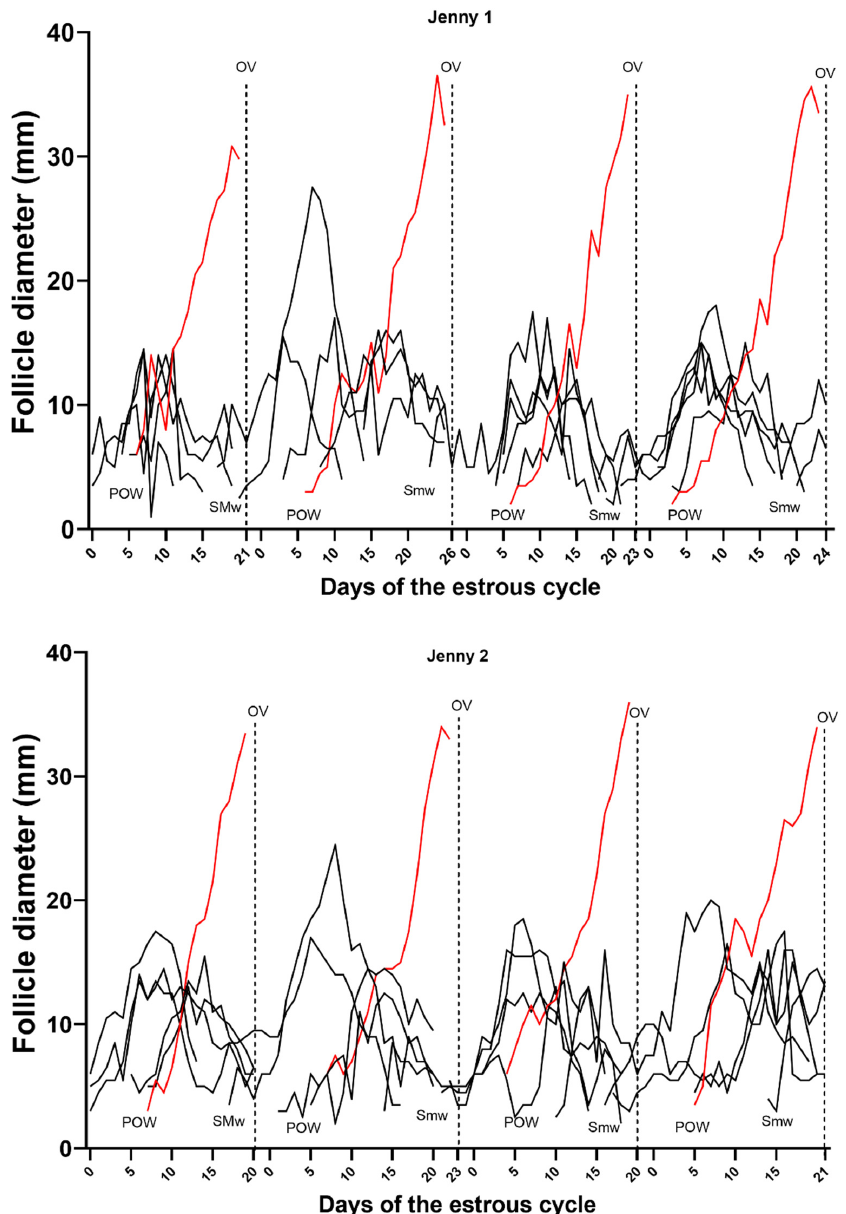
Figure 2. Profile of individually tracked follicles of two selected Caribbean jennies during four inter-ovulatory intervals (IOIs). The types of follicular waves characterized by inspection of the follicle data (with identity) are shown during each IOI for each jenny. The red line represents the dominant follicle of each wave. POW, primary ovulatory wave; SMw, major secondary wave; Smw, minor secondary wave; OV, ovulation.